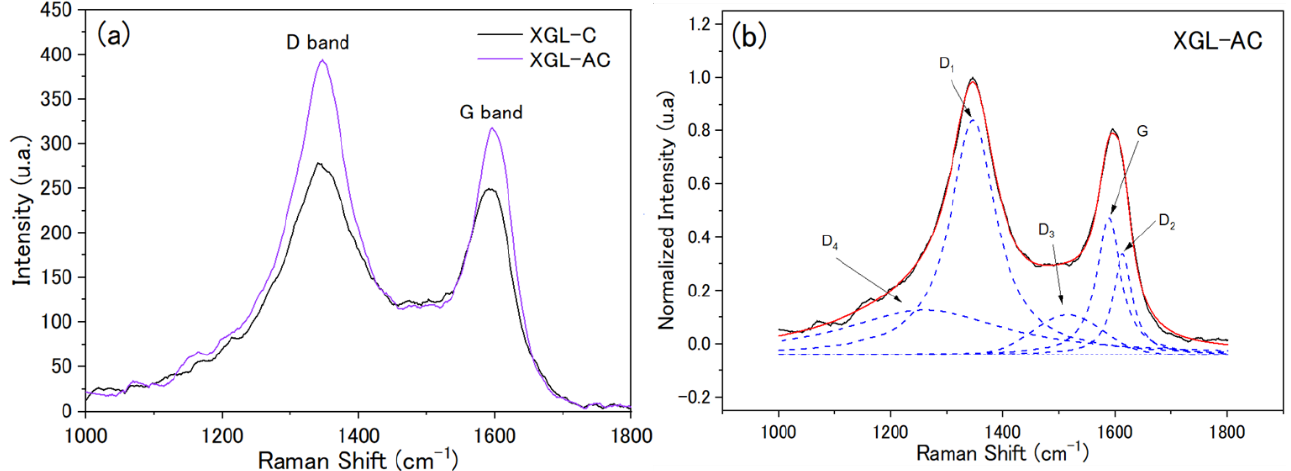
Figure 4. Raman spectra of ( a ) XGL-C and XGL-AC and ( b ) the deconvoluted spectra of XGL-AC.